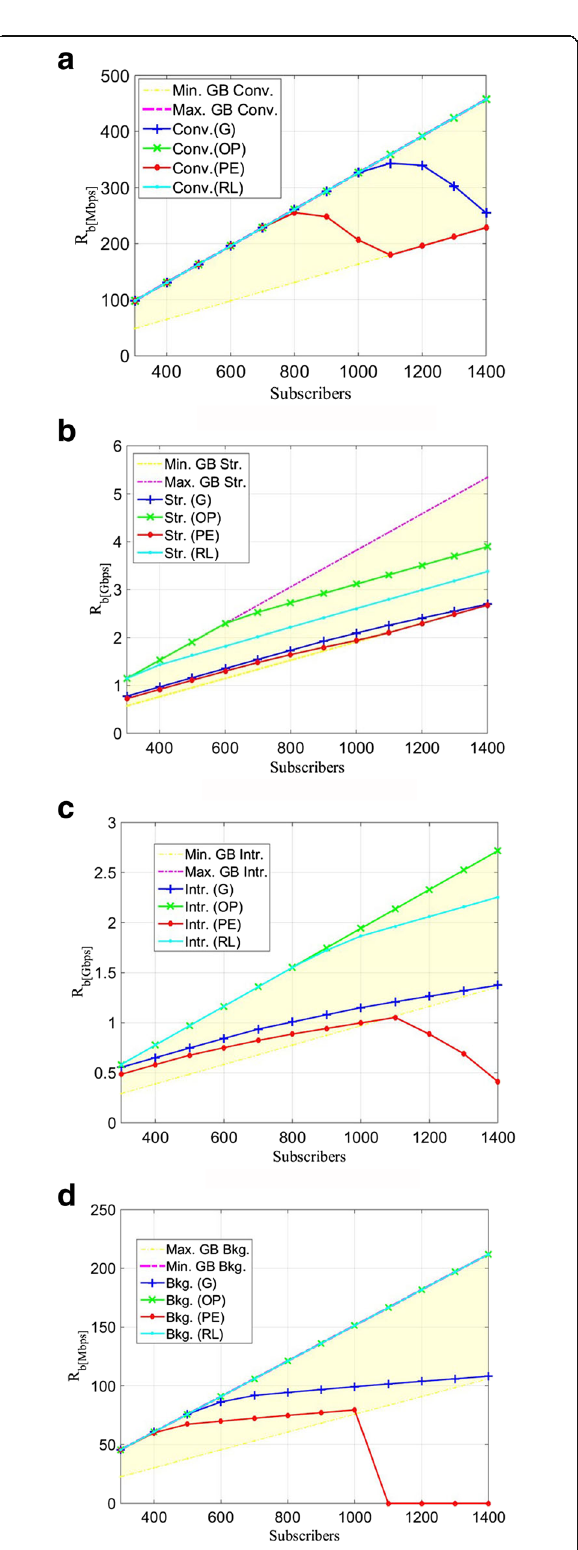
Fig. 10 The data rate allocated to service classes of VNO GB. a Conversational service class. b Streaming service class. c